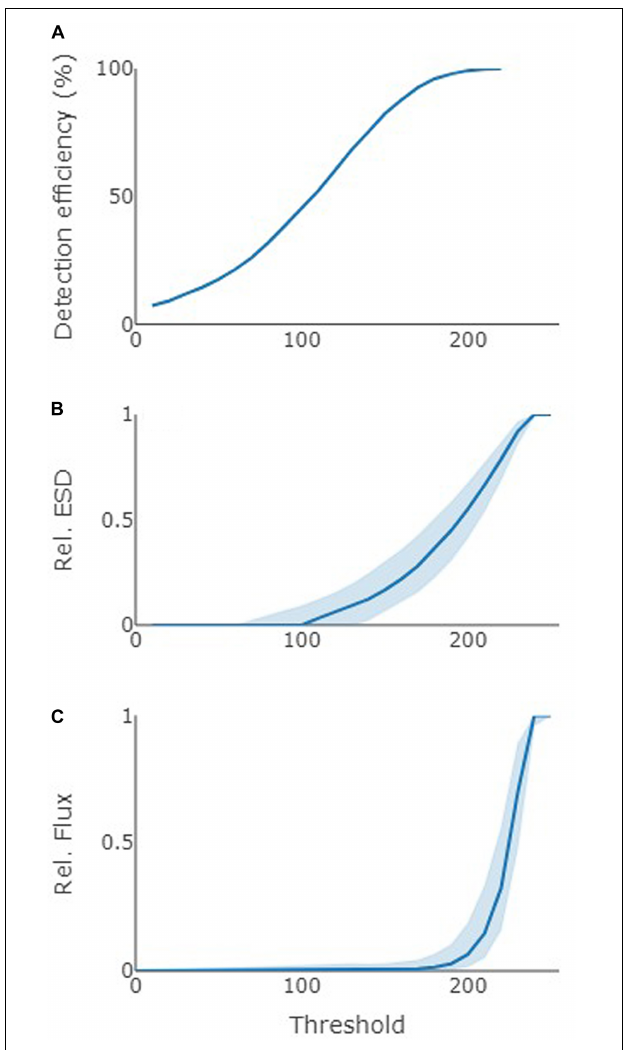
FIGURE 4 | Effect of changing static threshold on (A) detection efficiency (% of total particles), (B) particle ESD (px), and (C) particle-specific POC flux (mg C m − 2 d − 1 ). All values were normalized to those calculated with a threshold of 250. Lines show the median. Blue polygon encompasses upper and lower quartile. Based on all imaged particles ( n = 6400).